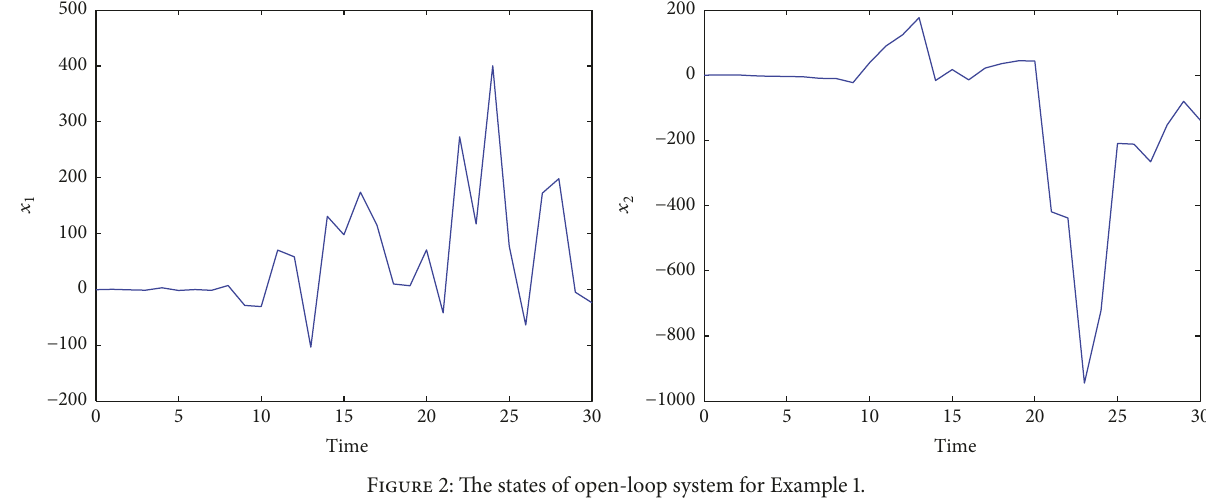
Figure 2: The states of open-loop system for Example 1.